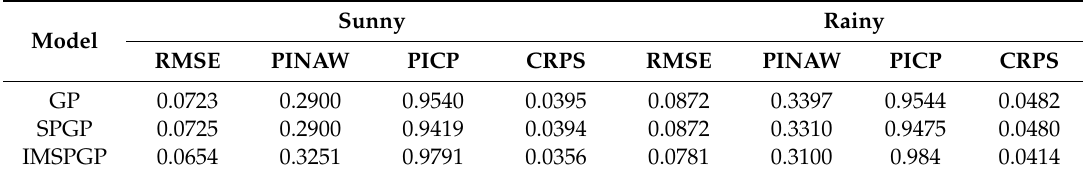
Table 2. Prediction results of GP, SPGP, and IMSPGP models for May.